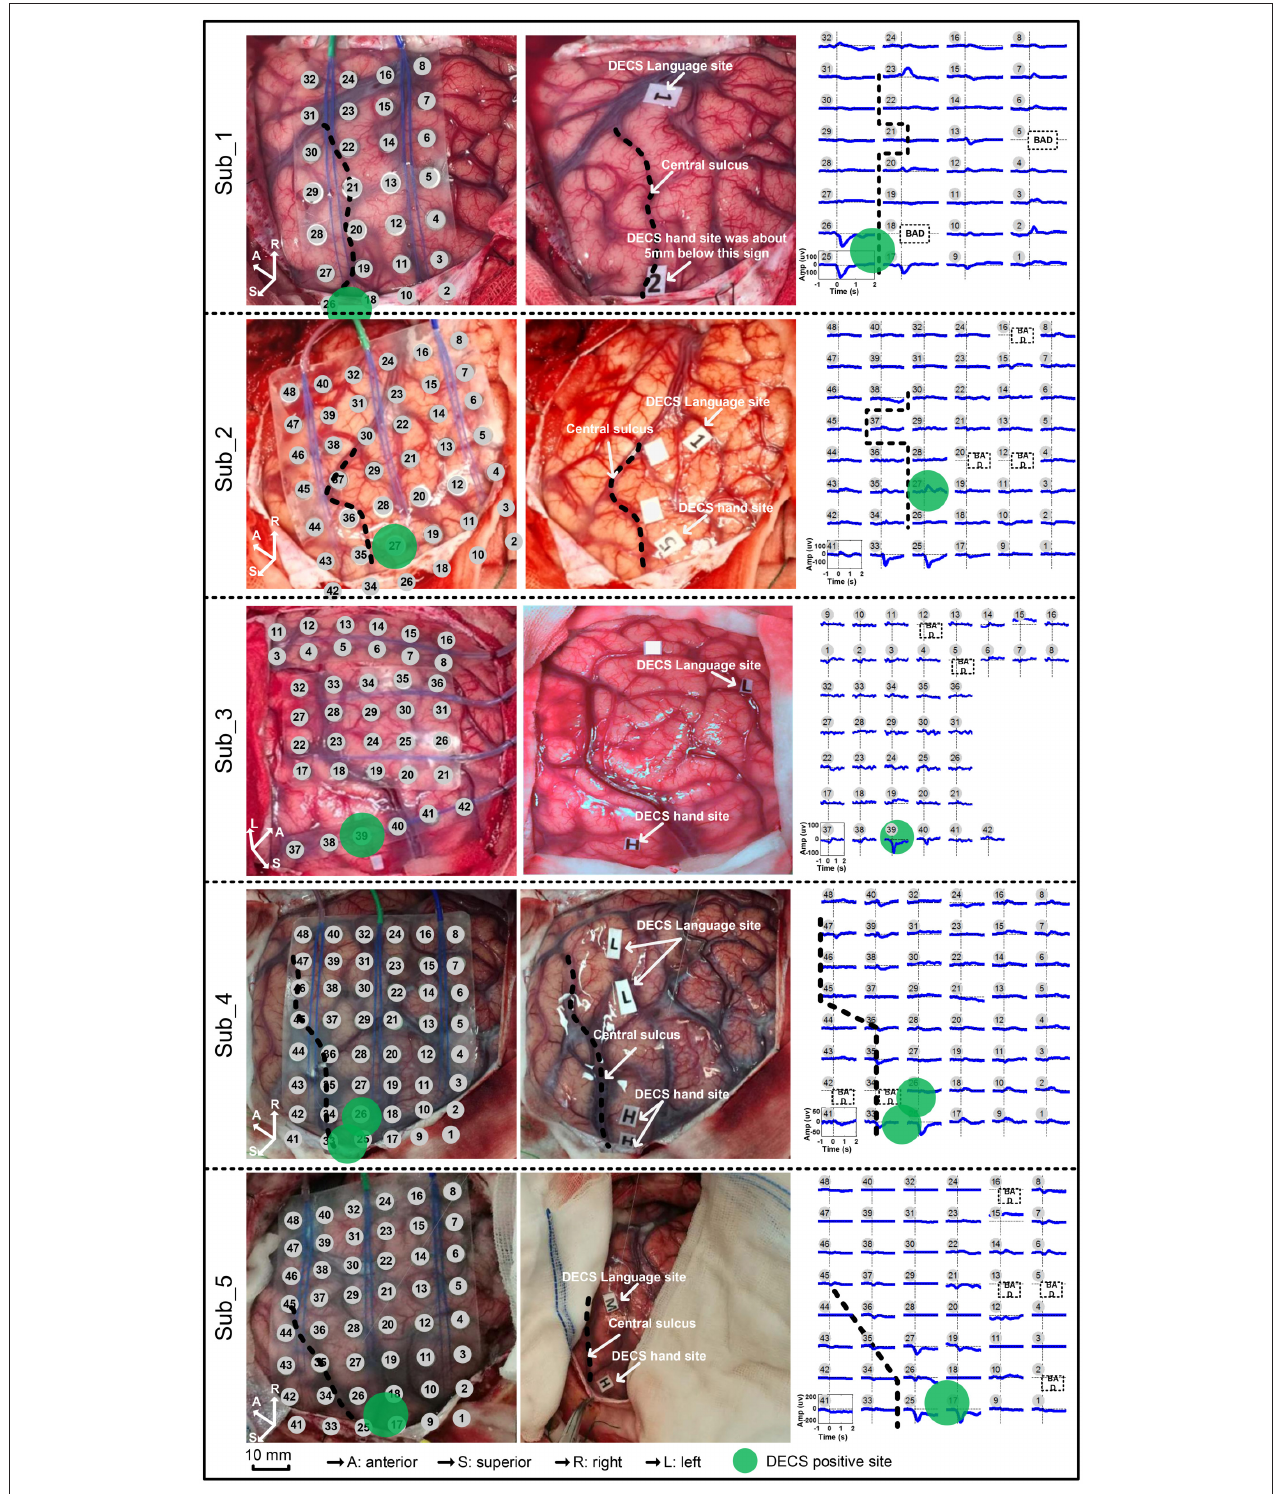
FIGURE 2 | Movement-related cortical potentials (MRCPs) and its cortex distribution for all five subjects. Left : the electrode array on the cortex. Middle : the direct electrocortical stimulation (DECS) positive sites of wrist extension. Right : the MRCPs across all channels.